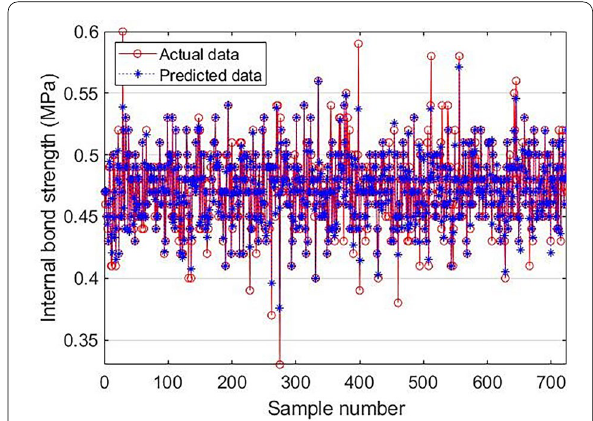
Fig. 6 Comparison between the experimental and predicted values of the training set based on the GRA–SVR model